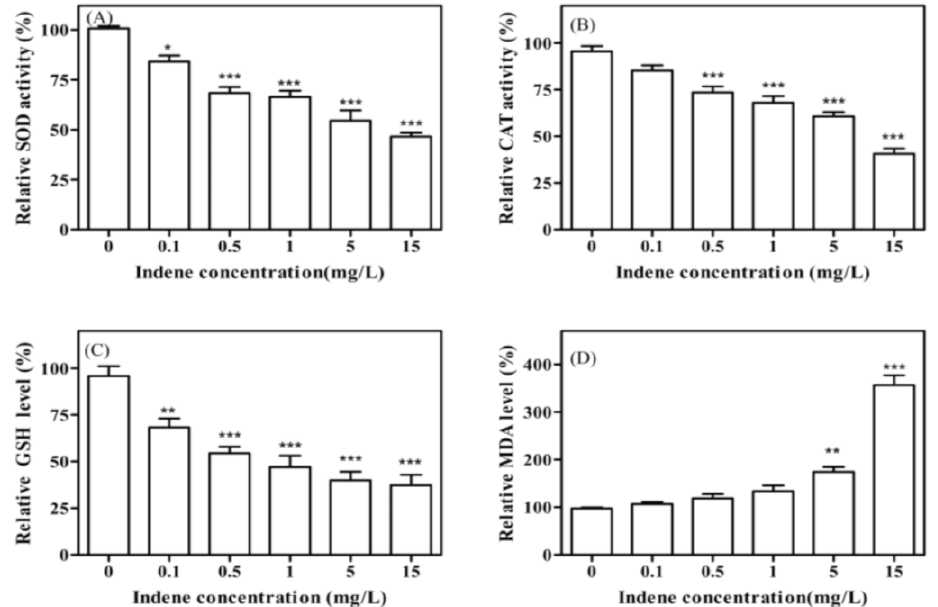
Figure 2. Activity changes of antioxidant enzymes and MDA level in coelomocyte after 24 h IND exposure. ( A ) SOD, ( B ) CAT, ( C ) GSH, ( D ) MDA level. Values are means ± SEM ( n = 3). Differences are considered statistically significant at p < 0.05, p < 0.01 and p < 0.001 and labeled with * and ** and ***,